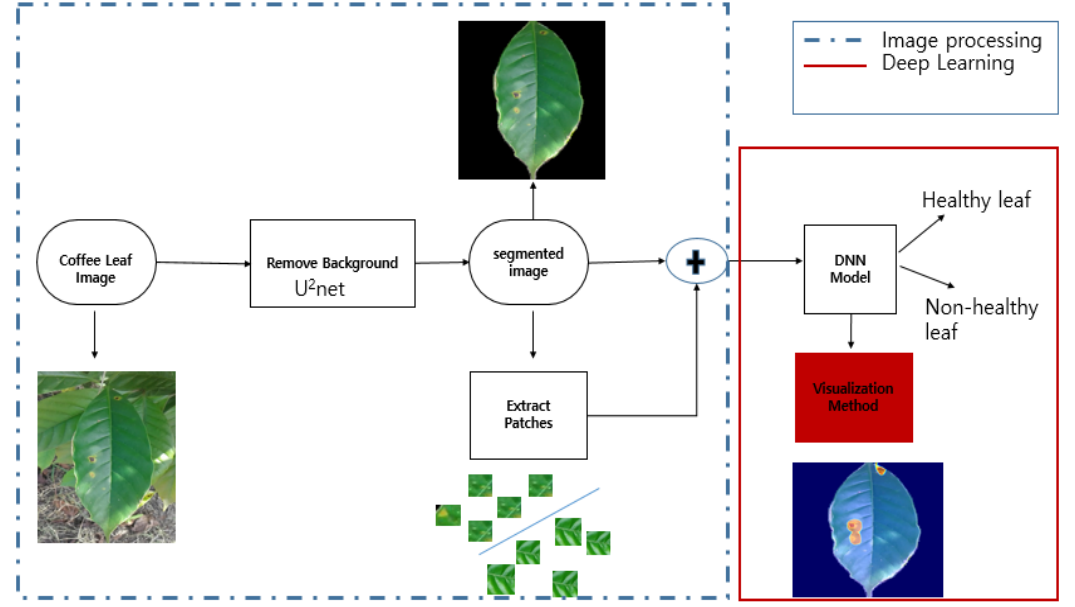
Figure 8. The pipeline of the proposed approach.